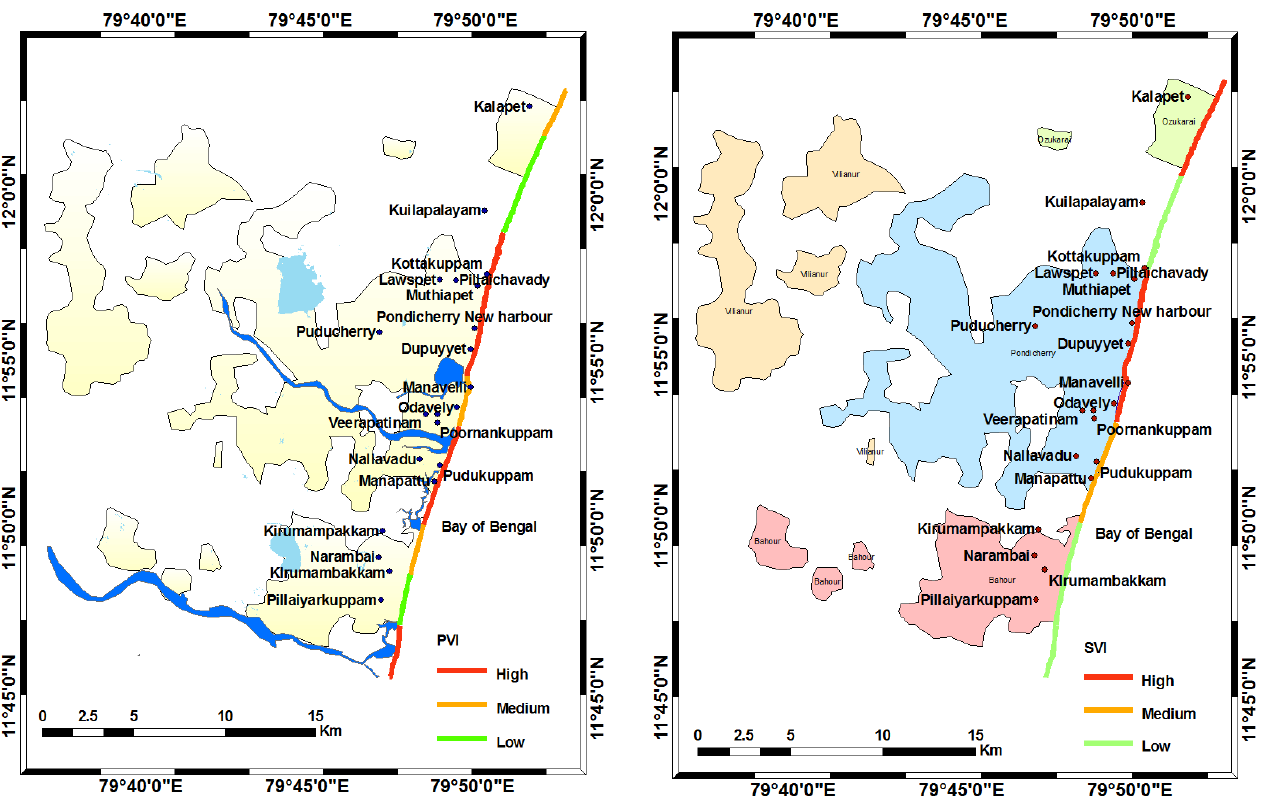
Fig. 11. Physical vulnerability index map. Fig. 12. Socio-economic vulnerability index